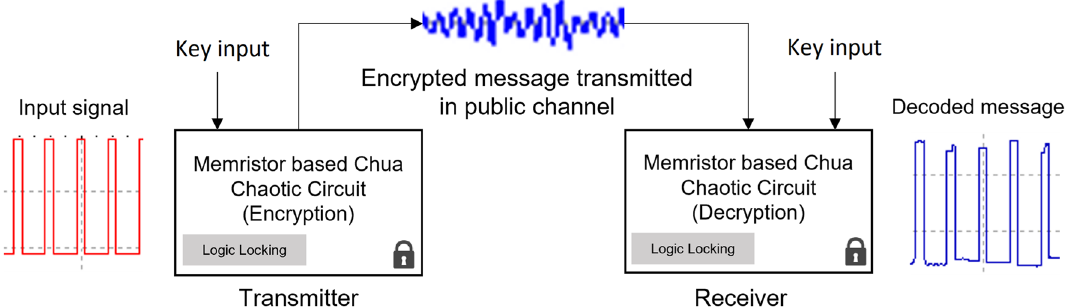
Fig. 1 Logic-locked memristor-based Chua’s chaotic